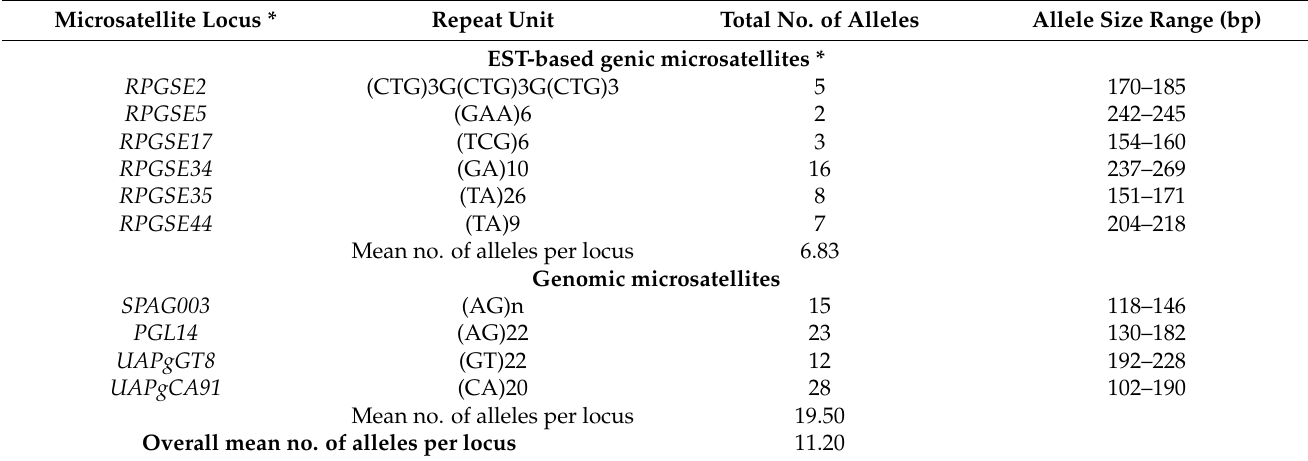
Table 2. Microsatellite DNA loci used, and the number and size of alleles detected at each microsatel- lite DNA